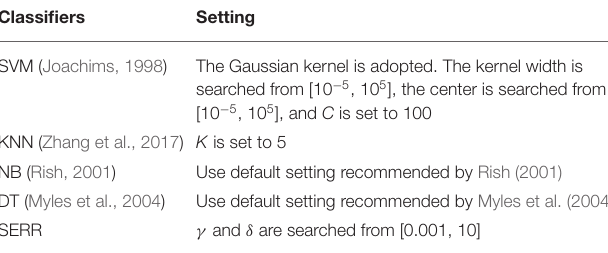
Algorithm 2: Model testing